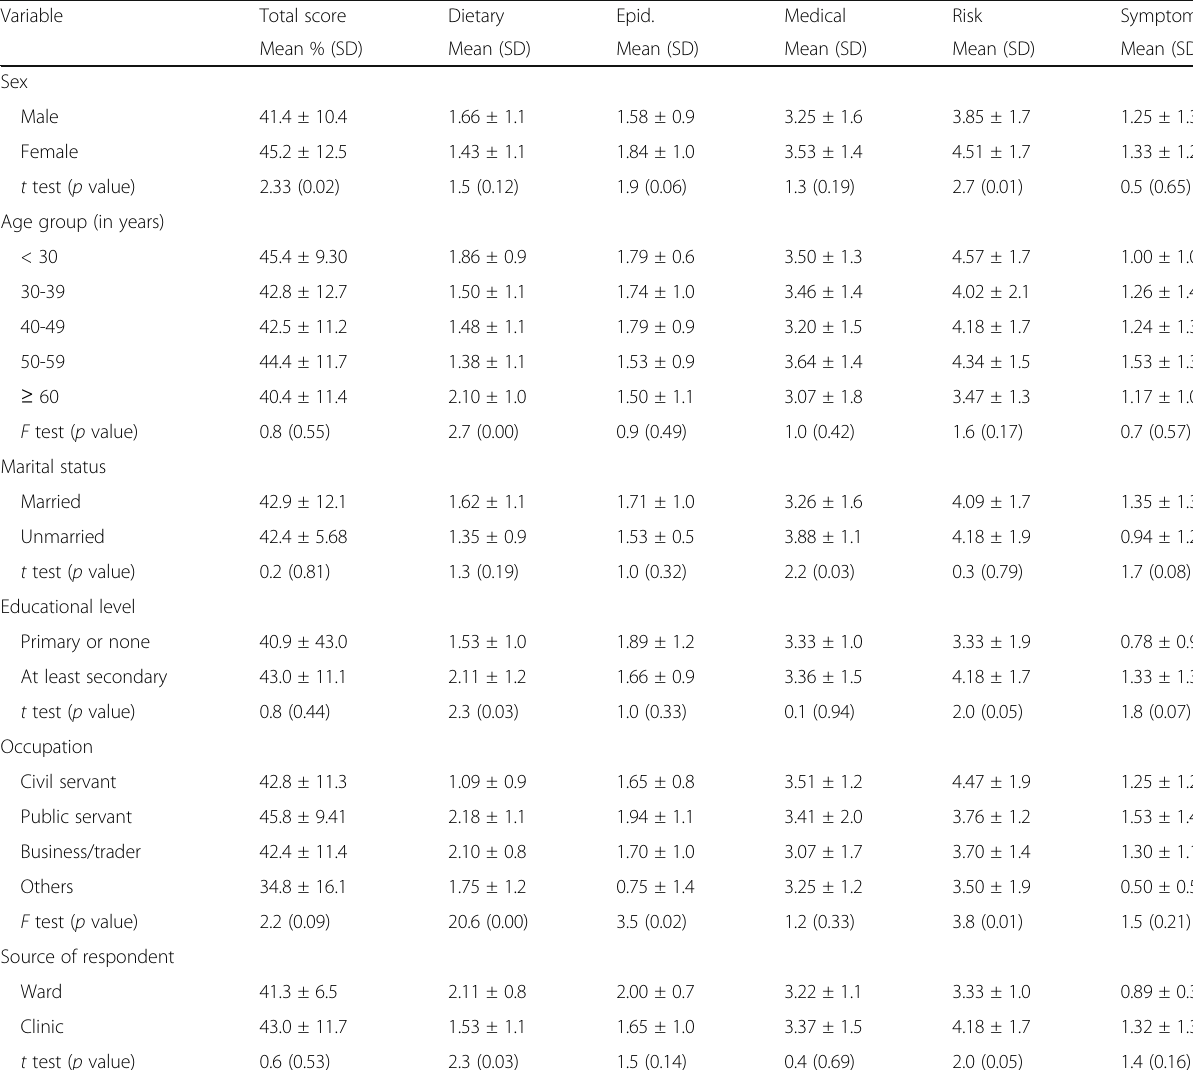
Table 5 Sociodemographic factors associated with knowledge of CVD ( N = 212) Variable Total score Dietary Epid.